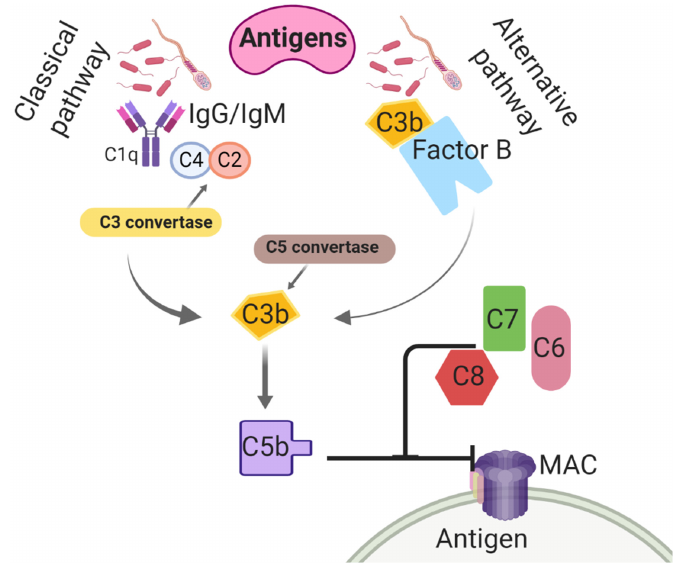
Figure 1. Classical and alternative complement activation pathways taking place in the uterine lumen of mares post-breeding. C1q: Complement component 1; C2: Complement 2; C3: Complement 3; C4: Complement 4; C5: Complement 5; C6: Complement 6; C7: Complement 7; C8: Complement 8; IgG: immunoglobulin G; IgM: immunoglobulin M; MAC: membrane attack complex.